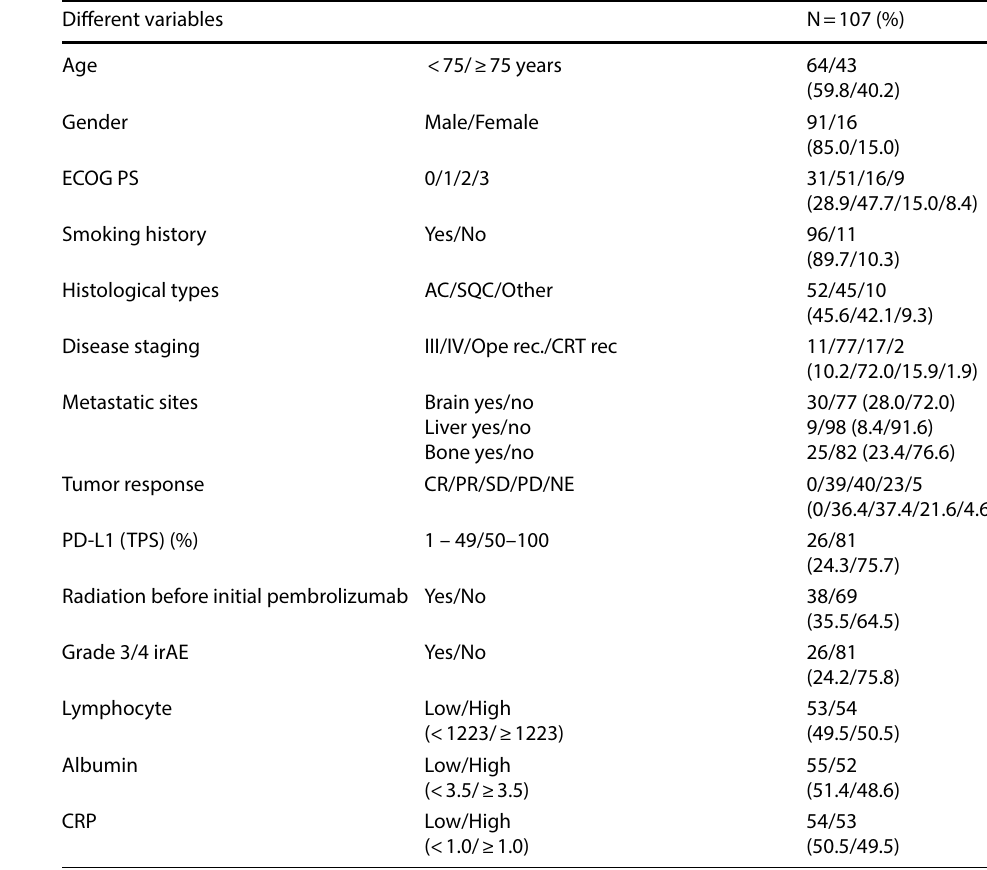
Table 1 Patient’s